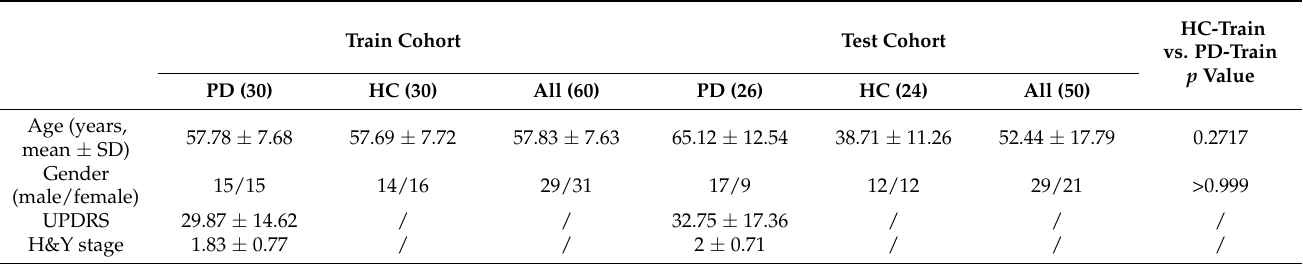
Table 1. Basic characteristics of patients and